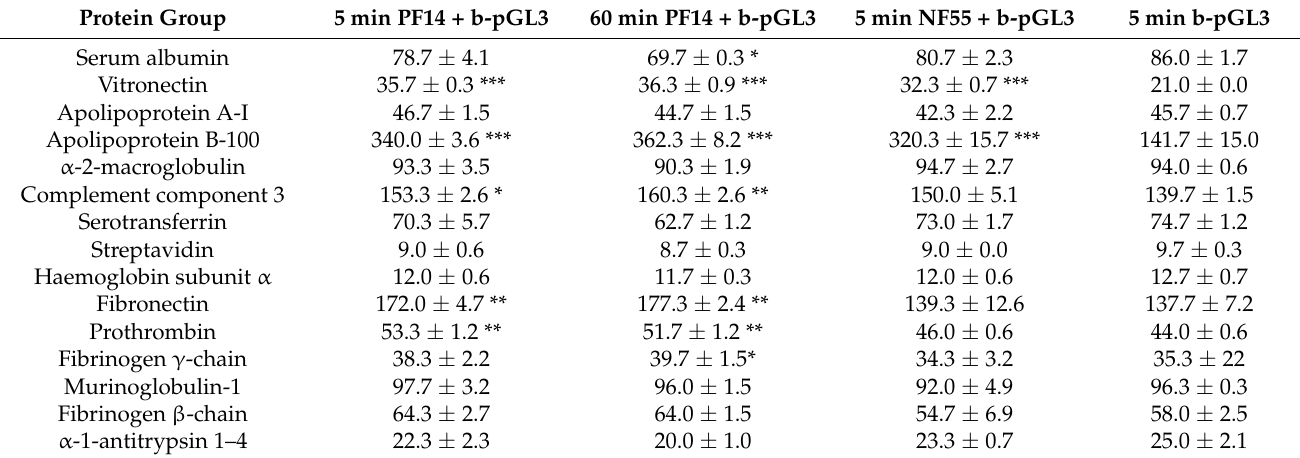
Table 5. Mass-spectrometry analysis of proteins bound to CPP-pDNA nanoparticles from murine serum at higher level. Fifteen most abundant proteins in protein corona are listed. Data represents two independent experiments and three technical replicates of each with ± SEM, compared to b-pGL3. * p -Value < 0.05, ** p -Value < 0.005, *** p -Value < 0.0005. Protein